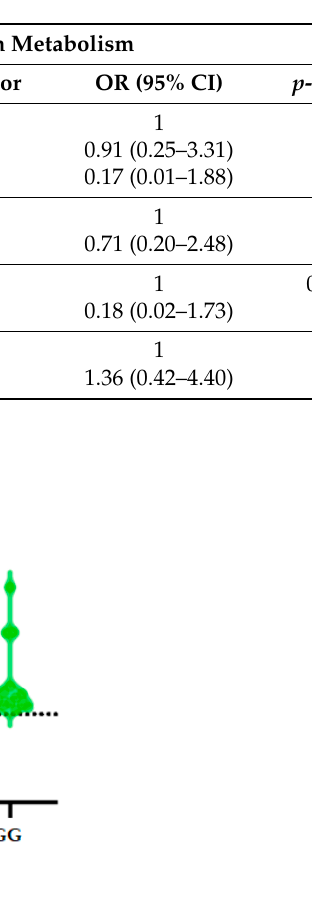
Table 6. Analysis of association of SULT1A1_rs3760091 polymorphism with the excretion of phase II flavanone metabolites in urine of studied volunteers after a single dose of orange juice.